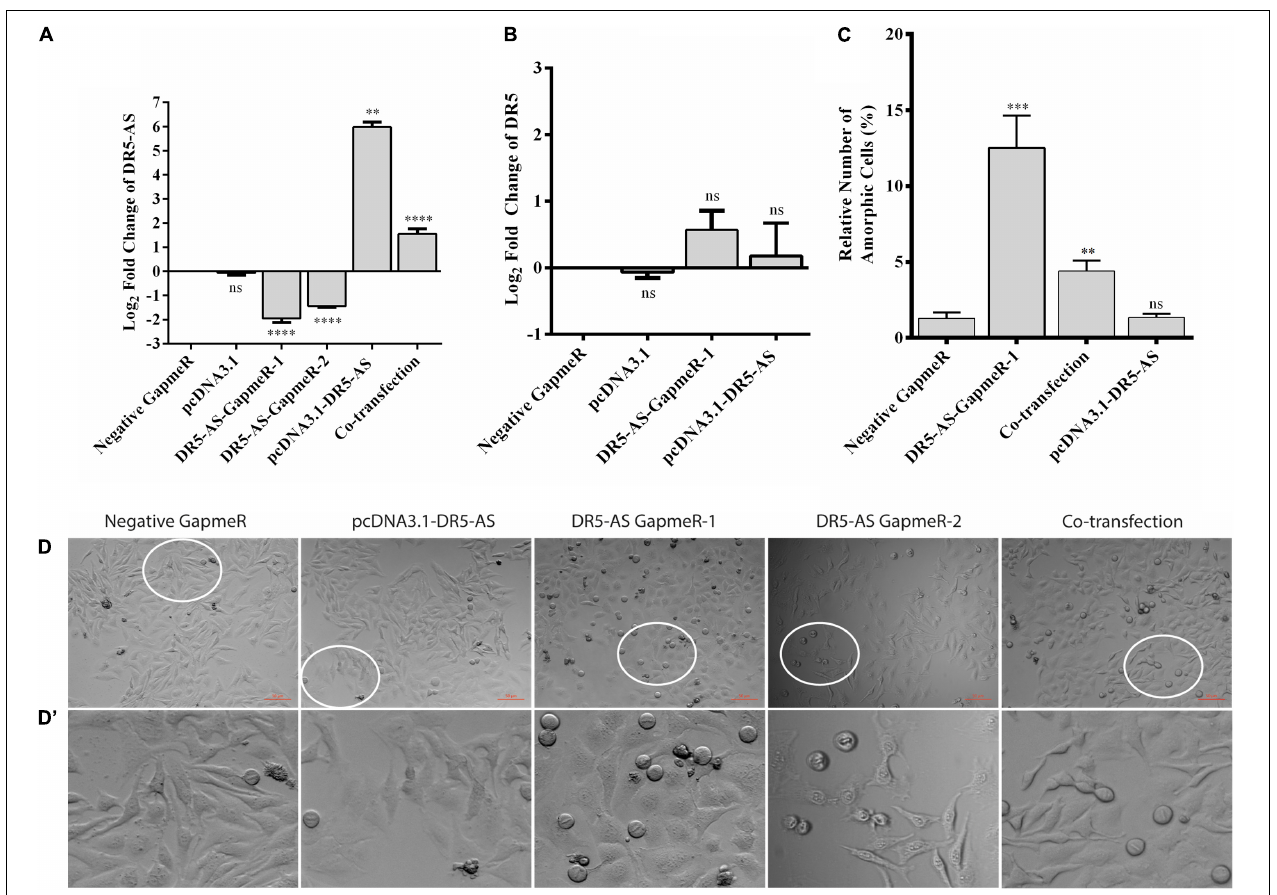
FIGURE 4 | DR5-AS knockdown modulates cell morphology in HeLa cells. (A) qPCR analyses of DR5-AS expression. HeLa cells were transfected with various GapmeRs or overexpression vectors for 72 and 48 h respectively and the amount of DR5-AS transcript was measured with qPCR. (B) qPCR analyses of DR5 sense mRNA expression. HeLa cells were transfected as explained in Figure 4A and DR5 expression was measured by qPCR. (C) Quantitative number of metaphase block cells in DR5-AS knockdown (DR5-AS-GapmeR-1), overexpression (pcDNA3.1-DR5-AS), and co-transfection groups. The same number of cells were visually counted under the microscope from at least three different regions and the percentage of amorphic cells was plotted. (D) Brightfield images of transfected cells after incubation period. (D’) The magnified areas of the parts encircled in white. Scale bar 50 µ m. Negative GapmeR was used as negative control for transfection. pcDNA3.1 represents the empty vector for overexpression. ns, non-significant, p > 0.05, ∗∗ p ≤ 0.01, ∗∗∗ p ≤ 0.001, and ∗∗∗∗ p ≤